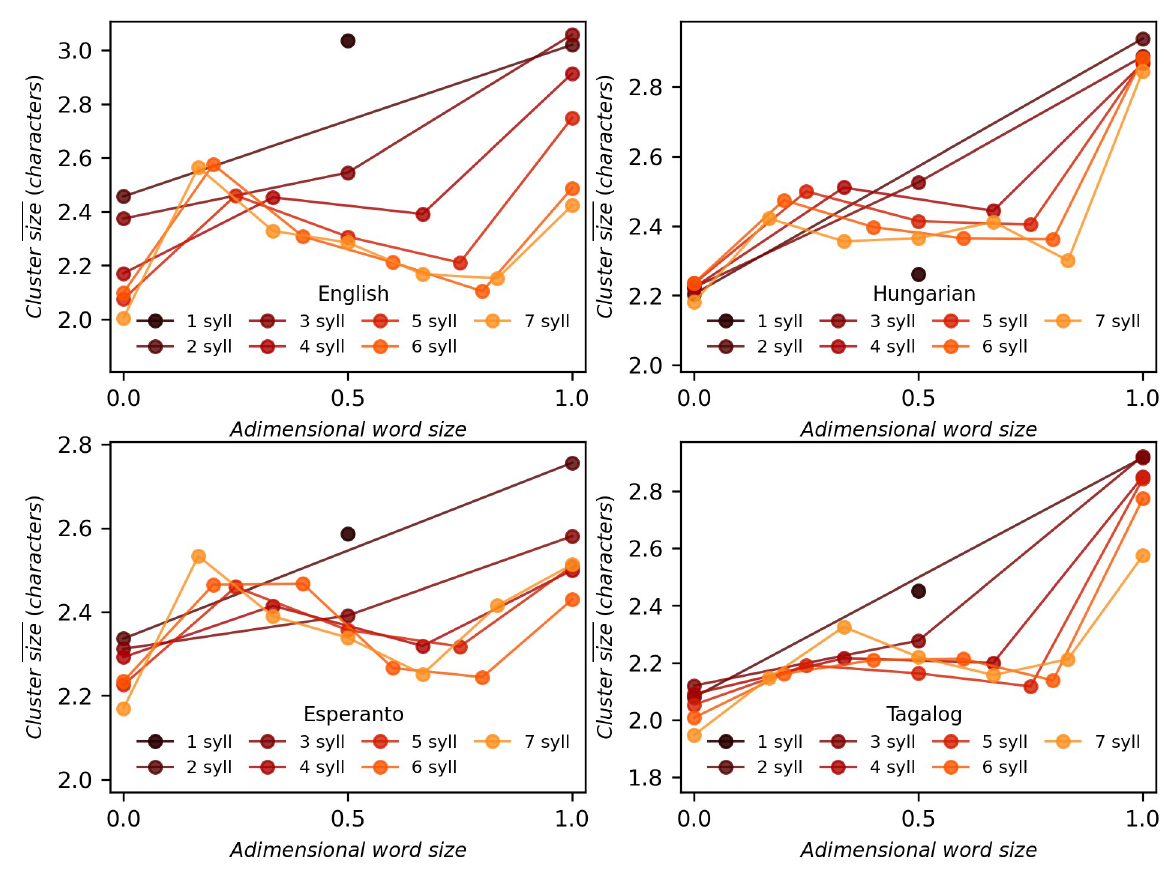
Fig 5. Syllable sizes depending on word length and position. The mean size of syllables in the number of characters for different word sizes and syllable positions for the case of English, Hungarian, Esperanto and Tagalog. The position in the word has been standardized according to Eq (6), 0 being the first syllable and 1 being the last syllable. The mean size value for monosyllabic words is represented with a black circle at x = 0.5. The results for 17 additional languages are provided in S4 Fig.